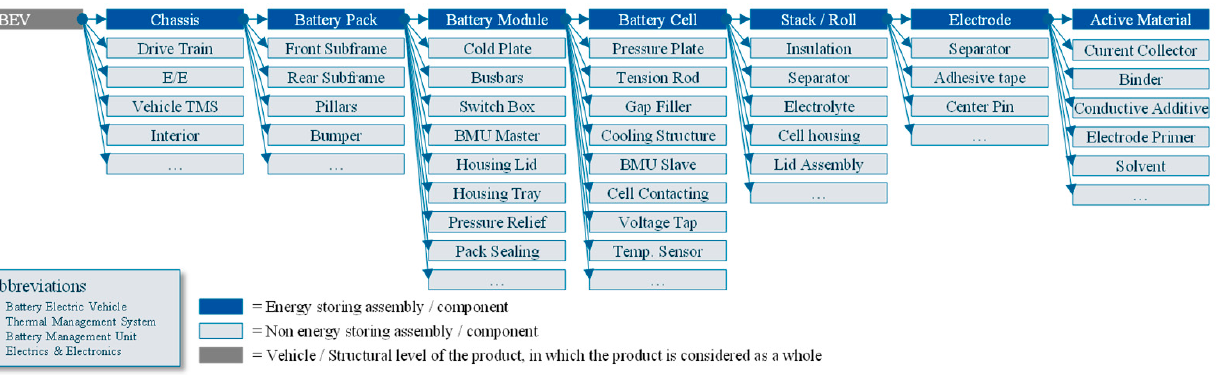
Figure 2. Detailed BEV product structure based on a conventional ba tt ery system architecture.